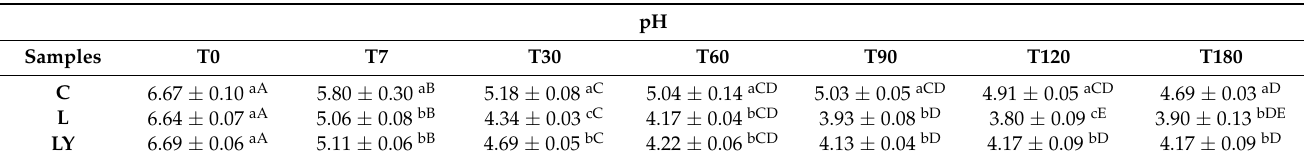
Table 1. pH values of brine samples of Nocellara Etnea table olives produced at an industrial scale with (L and LY) and without (C) stater culture